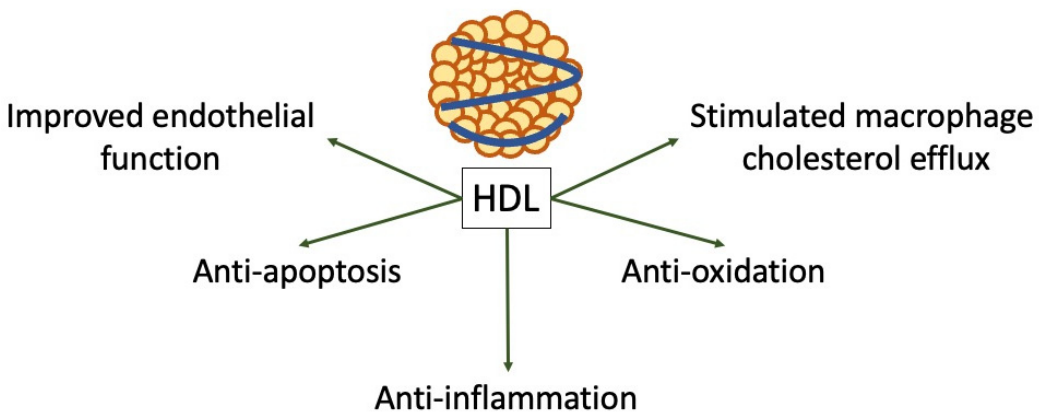
Figure 1. Anti-atherosclerotic effects of HDL.